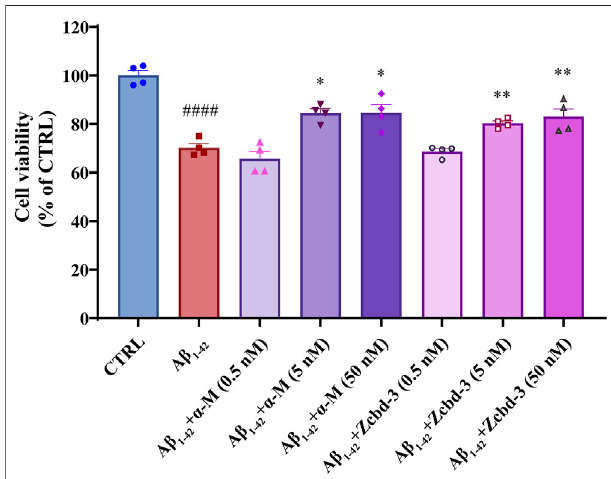
FIGURE 5 | α -M and its analogues rescued the A β 1-42 induced neurotoxicity in primary cultured cerebral cortical neurons from C57BL/6 mice. Primary cultured mouse cerebral cortical neurons were incubated with A β 1-42 oligomers (1 μ M) and various concentrations of α -M or Zcbd- 3 (0.5, 5, and 50 nM) for 24 h. Then the cell viability was measured by CCK-8 assay. All data represent mean ± SEM from 4 independent experiments. * p <